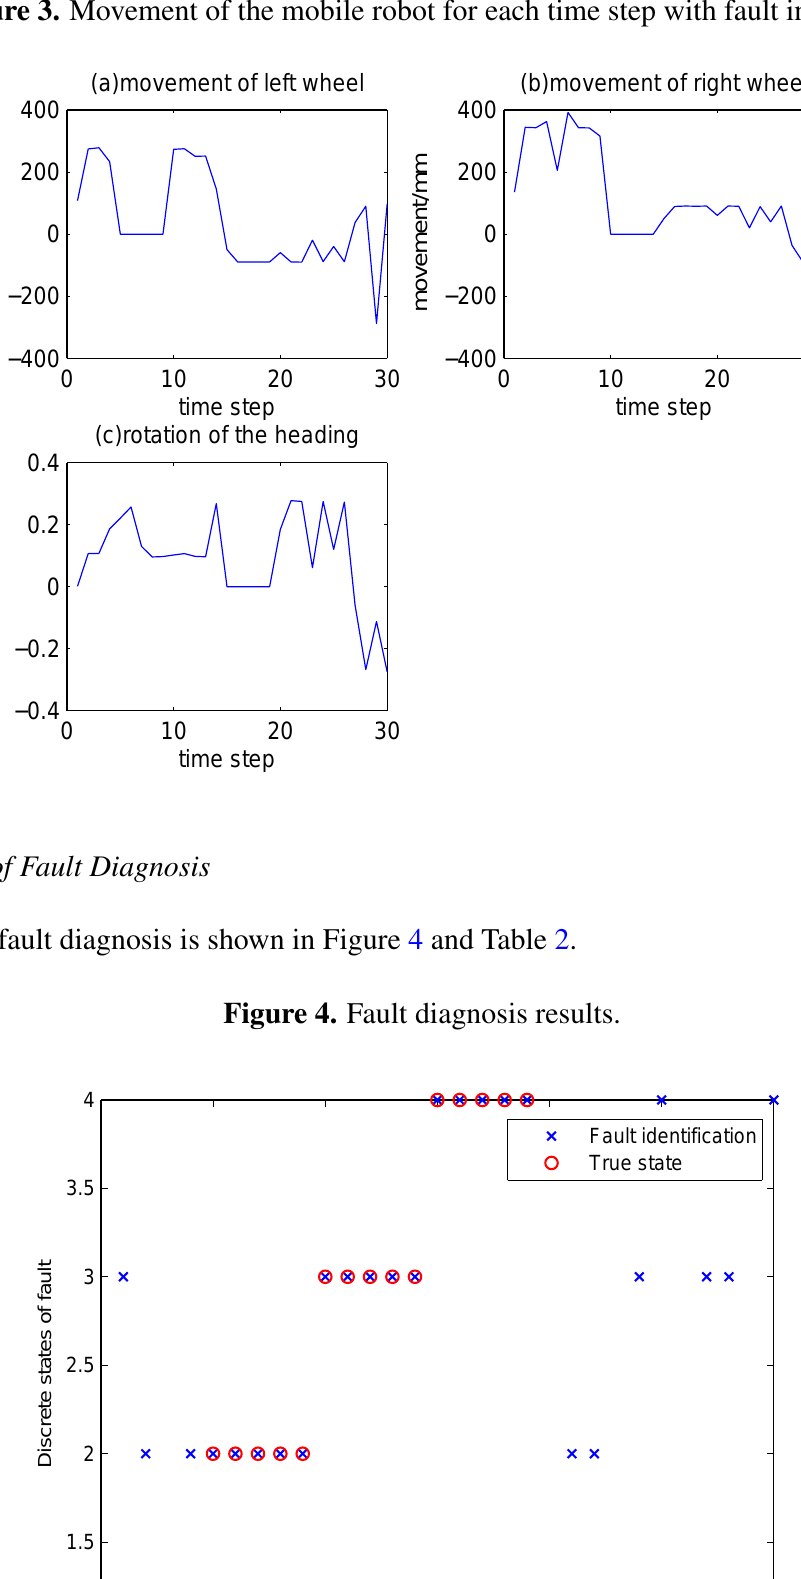
Figure 3. Movement of the mobile robot for each time step with fault injection.